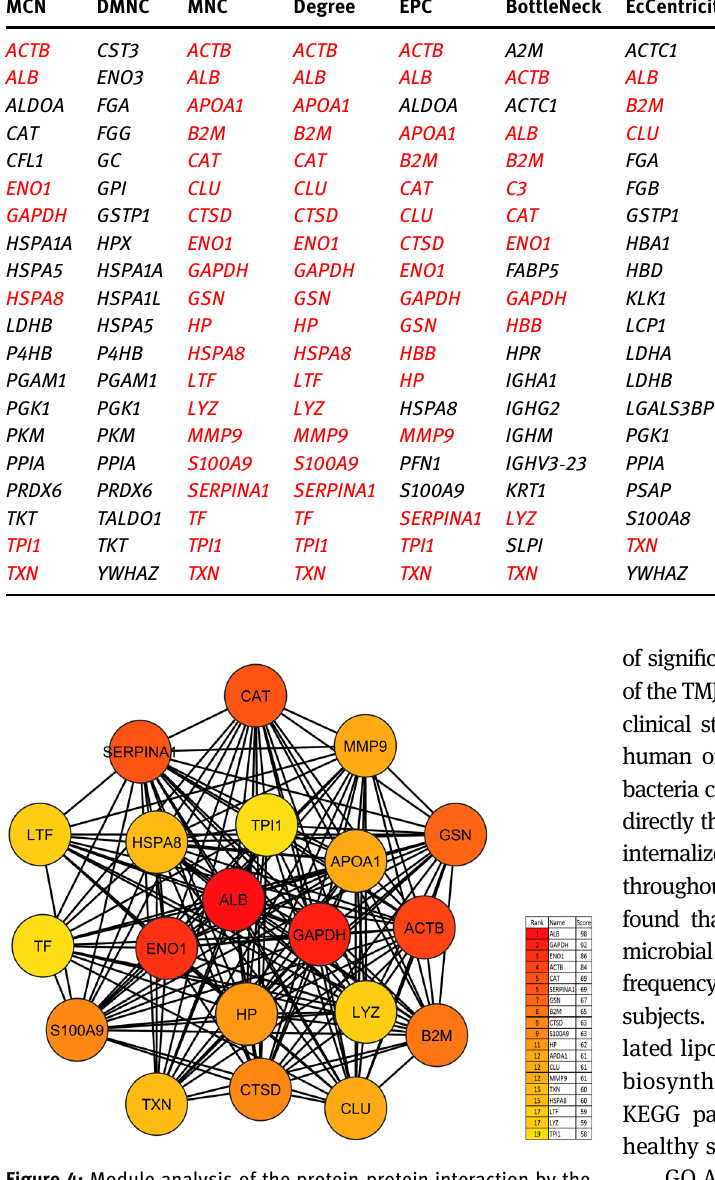
Figure 4: Module analysis of the protein - protein interaction by the cytoHubba plug - in. The PPI hub gene module of the top 20 genes ranked by MNC